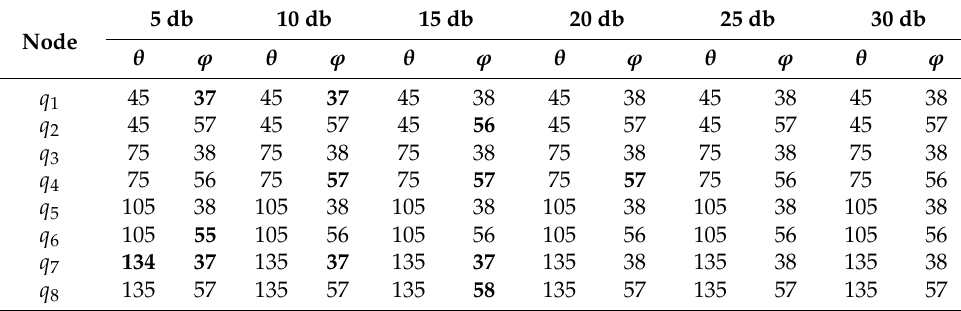
Figure 6. Clustering results with different SNR. Table 1. Identified sound source (cluster center) coordinates with different SNR.